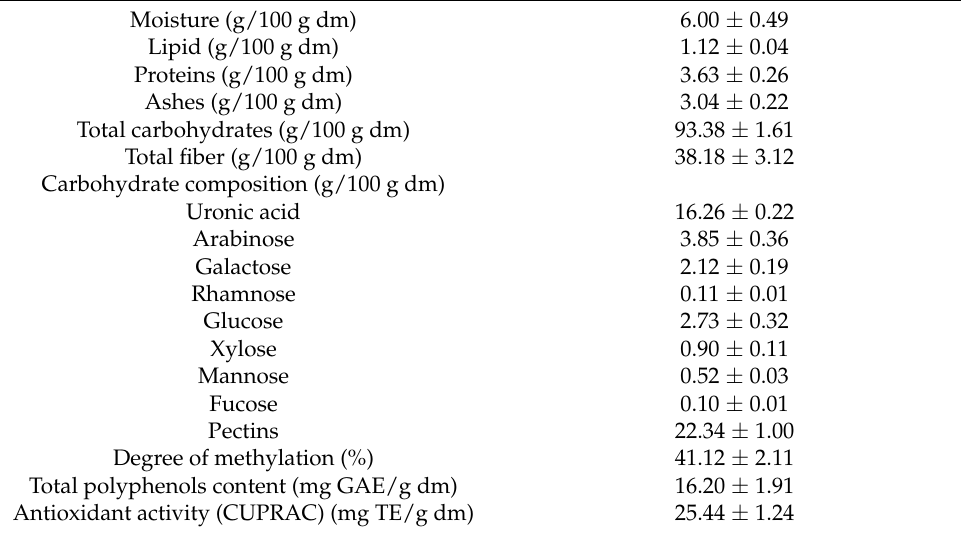
Table 2. Composition and antioxidant activity of the orange by-product flour